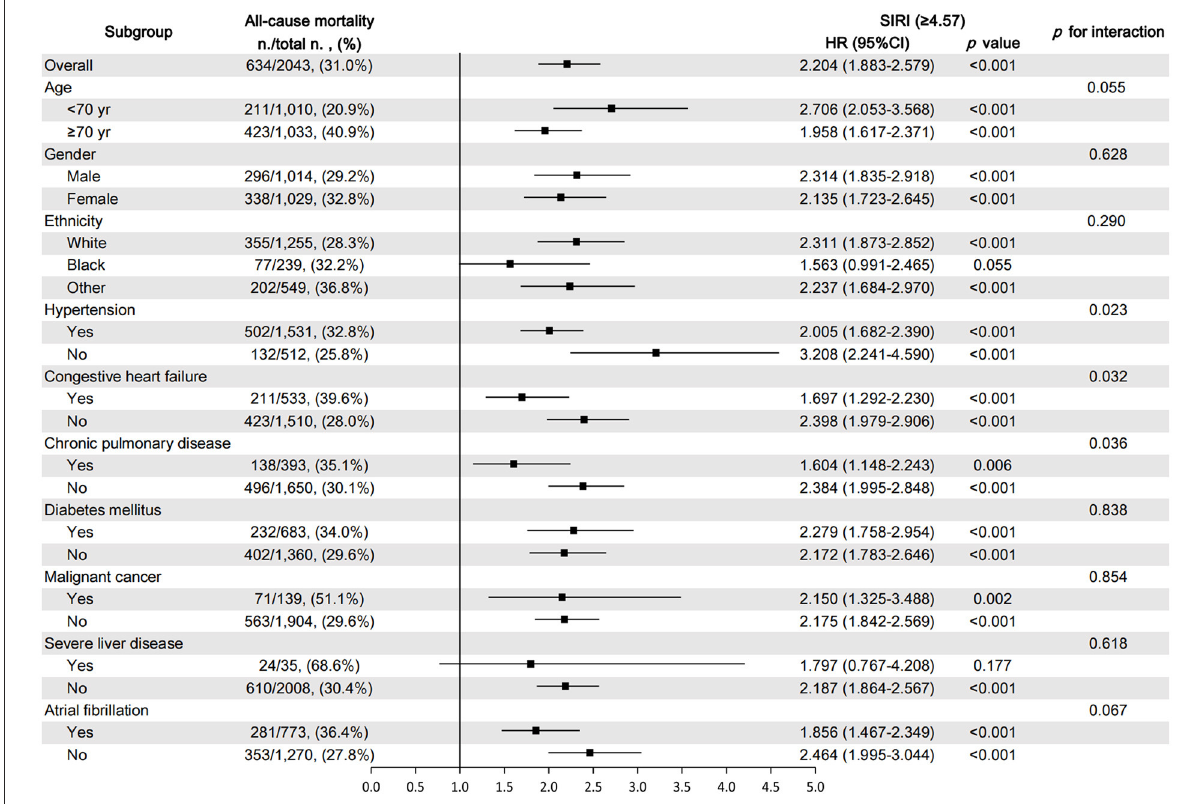
FIGURE6 Subgroup analysis for the effect of SIRI on 90-day all-cause mortality in critically ill patients with AIS.